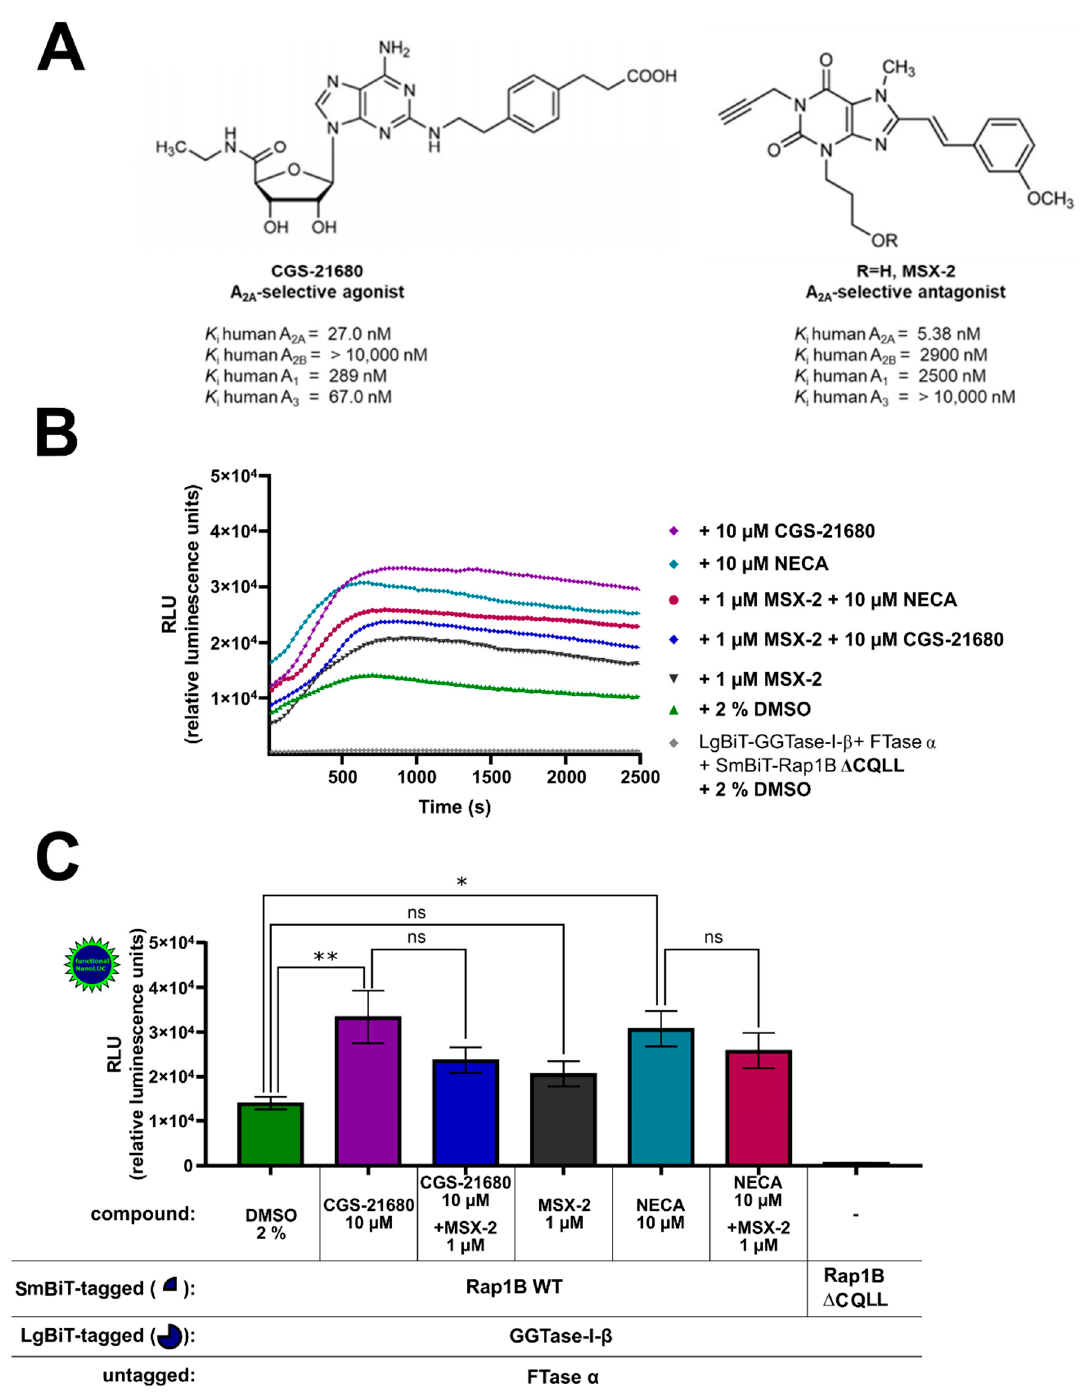
Figure 5. Effect of A 2A AR agonists and antagonists on the interaction of GGTase-I and Rap1B. HEK293 cells stably expressing the A 2B AR were transiently transfected as described above. ( A ) Selected A 2A AR-selective agonist 2-[ p -(2-carboxyethyl)phenylethyl-amino]-5 ′ - N -ethylcarboxamido adenosine (CGS-21680) and A 2A AR-selective antagonist (3-(3-hydroxypropyl)-7-methyl-8-( m -methoxystyryl)-1-propargylxanthine) (MSX-2) and their affinities at the different adenosine receptor subtypes [61,62]. ( B ) Twenty-four hours after transfection, the cells were pre-treated for 30 min with the selective A 2A AR antagonist MSX-2 (1 µM) or 1% DMSO at 37 °C in OptiMEM medium. Then the cells were stimulated for 15 min with the selective A 2A AR agonist CGS-21680 (10 µM) and the non-selective adenosine receptor agonist NECA (10 µM). The NanoGlo live-cell substrate was added, and the association was immediately monitored at 25 °C over a time period of 42 min, with a luminescence reading taken every 30 s. ( C ) After a time period of ~ 700 s, the maxima of complex formation were reached, and the relative luminescence units (RLU) were plotted. Significant differences were observed